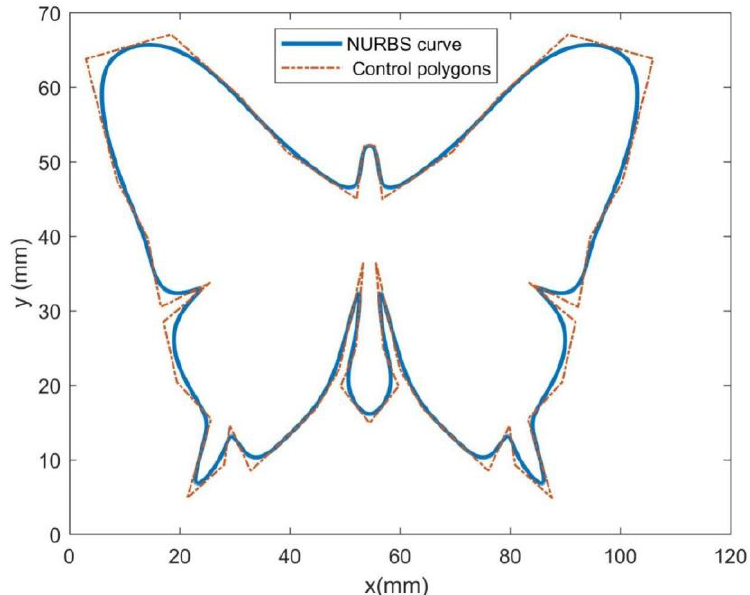
Figure 3. Butterfly-shaped NURBS curve.